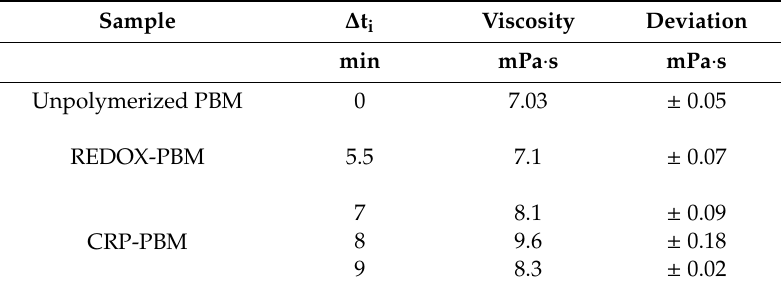
Table 2. Viscosity measurements depending on CRP